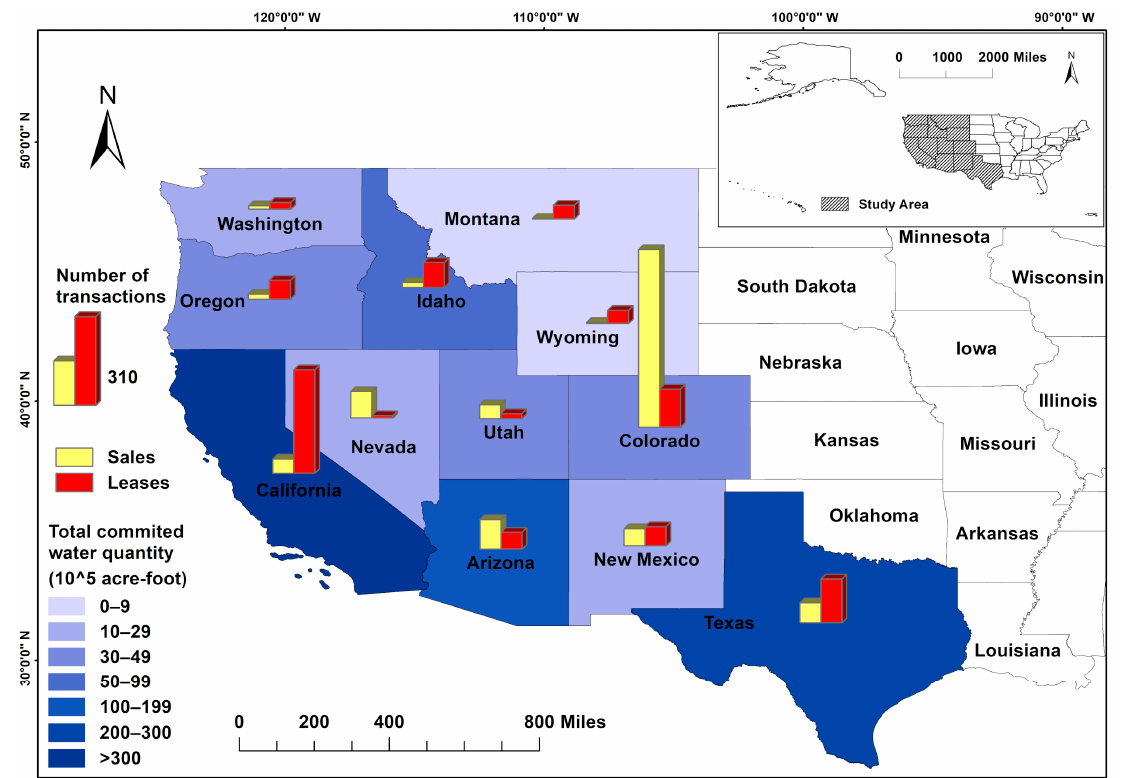
Figure 1. Total committed water quantity traded and numbers of transactions for each western state in the study area ( Water Strategist , 1987–2009).